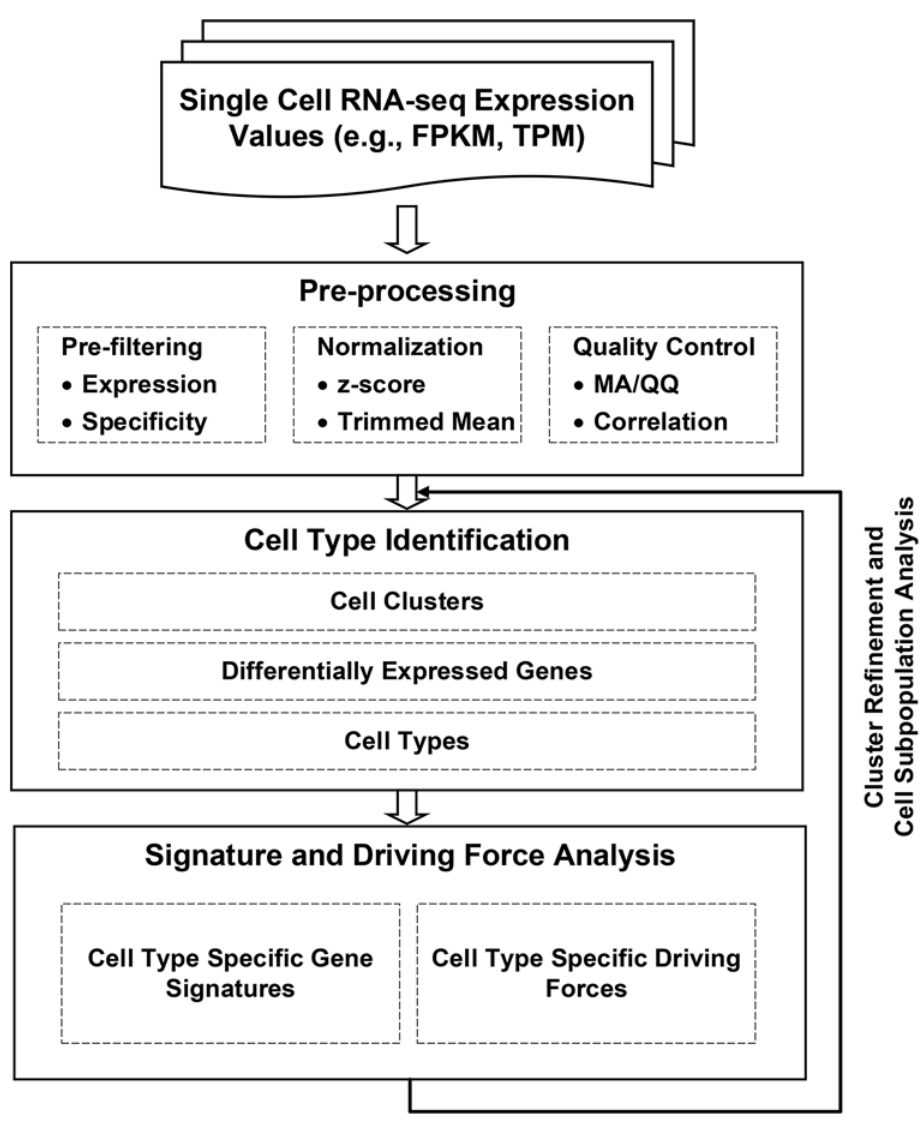
Fig 1. Schematic Workflow. The analytic pipeline consists of three main components: pre-processing, cell type identification, and cell type specific gene signature and driving force identification.